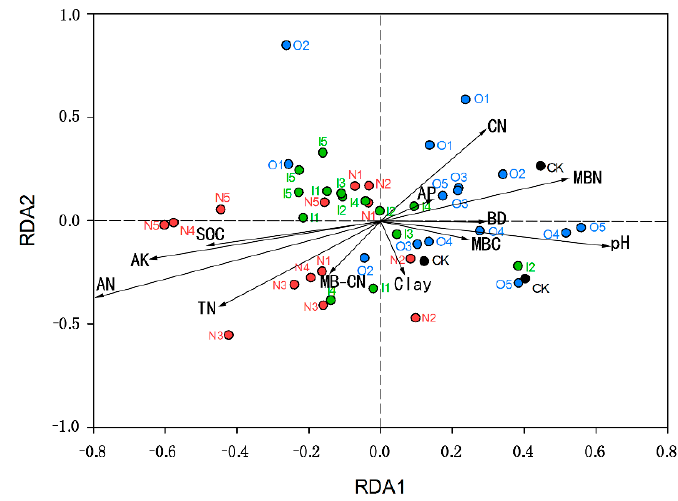
Figure 2. Redundancy analysis (RDA) of microbial communities using soil properties as environmental parameters. The different points color represents different management, which was consistent with Figure 1. The arrows represent soil properties, including carbon-nitrogen ratio (CN), available phosphorus (AP), microbial biomass nitrogen (MBN), bulk density (BD), microbial biomass carbon (MBC), microbial biomass carbon-nitrogen ratio (MB-CN), total nitrogen (TN), available nitrogen (AN), available potassium (AK), soil organic carbon (SOC). The circles were colored by managements, consistent with Figure